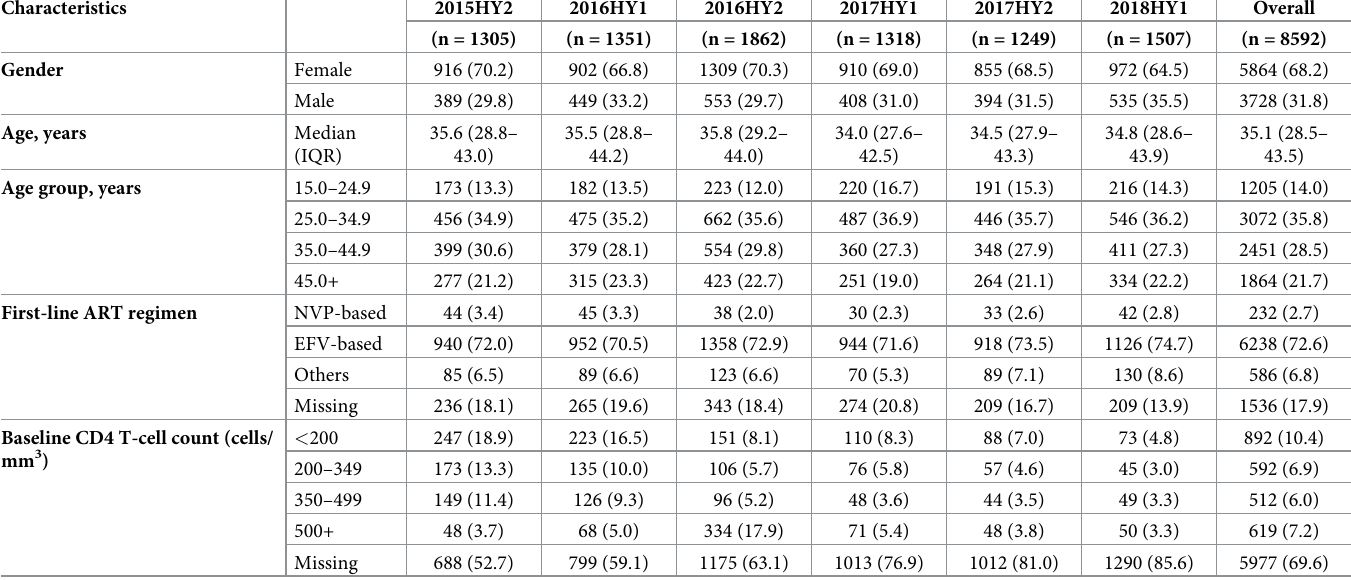
Table 1. Distribution of HIV infected adults initiating combination antiretroviral therapy and eligible for the analysis using data from the national data warehouse in Kenya (2015HY2 to 2018HY1, N = 8592). Characteristics